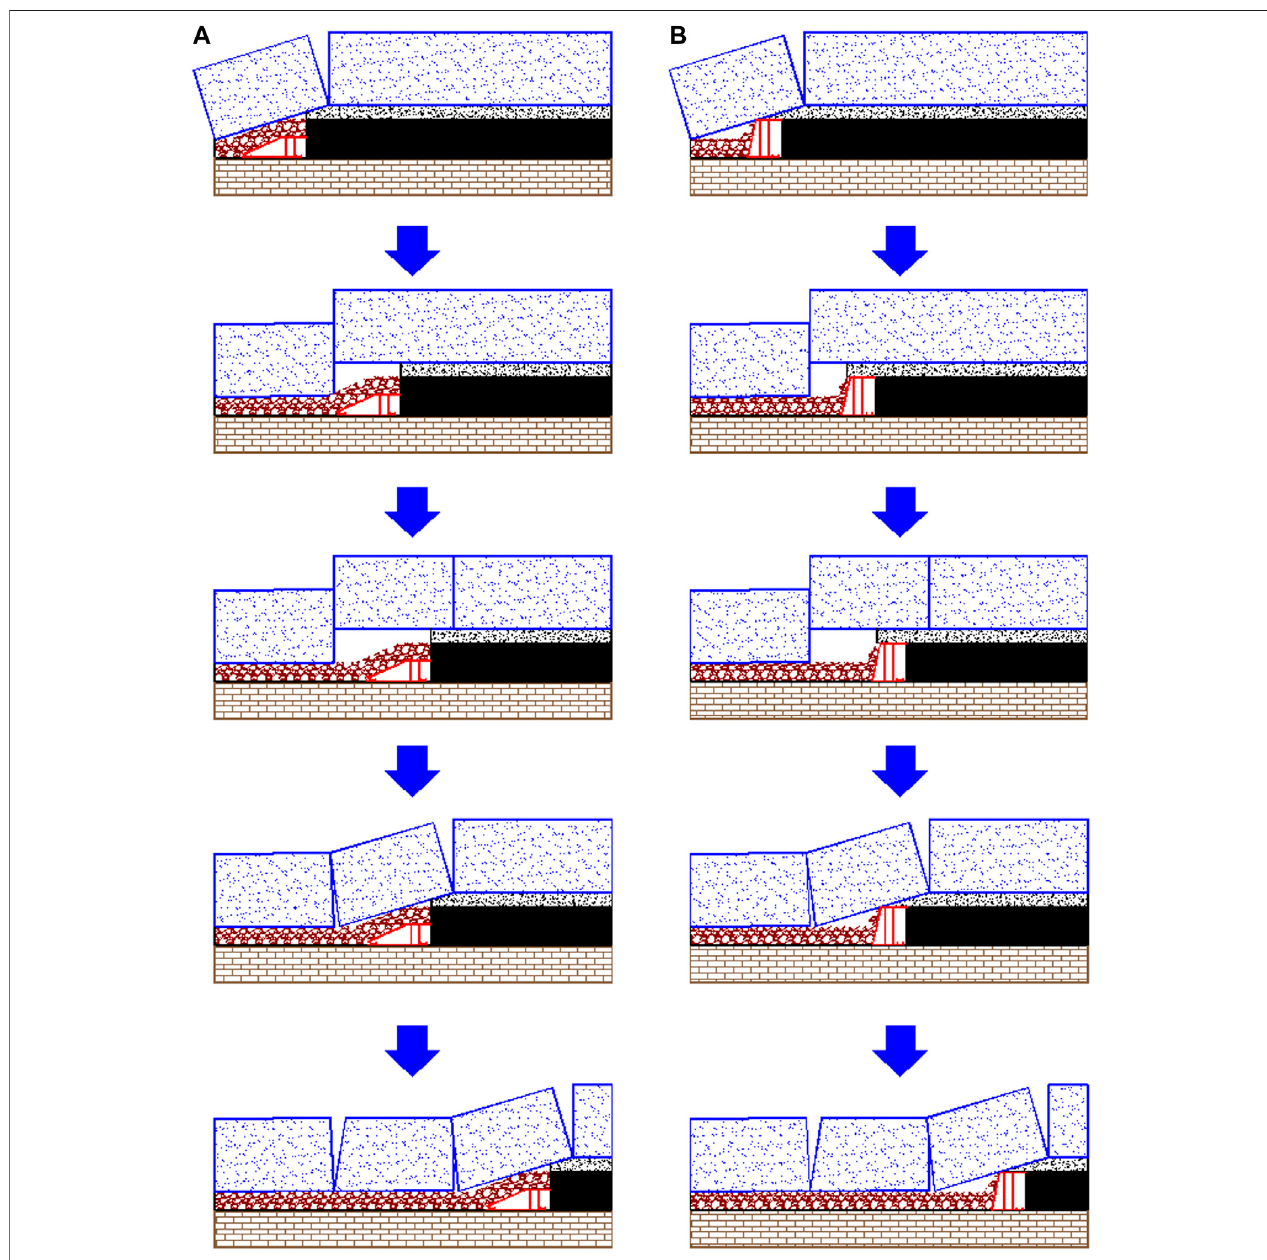
FIGURE 2 | Schematic diagram of periodic weighting process. (A) Top coal caving mining. (B) full height mining at one time.